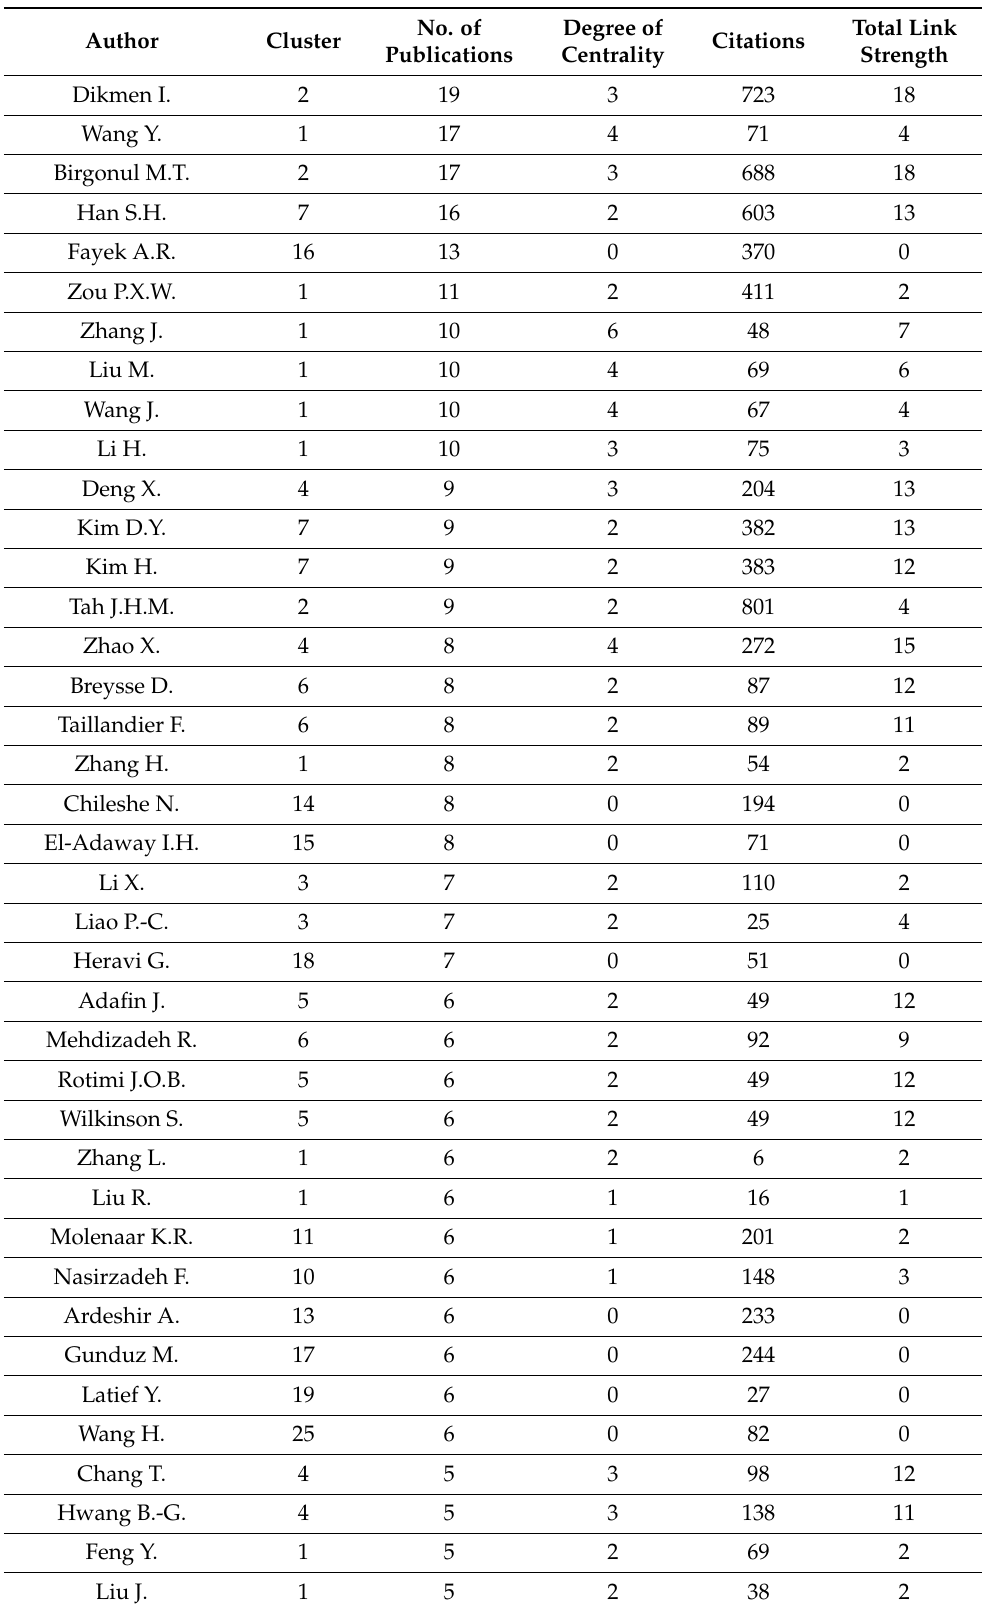
Table 2. Most productive authors in risk management in